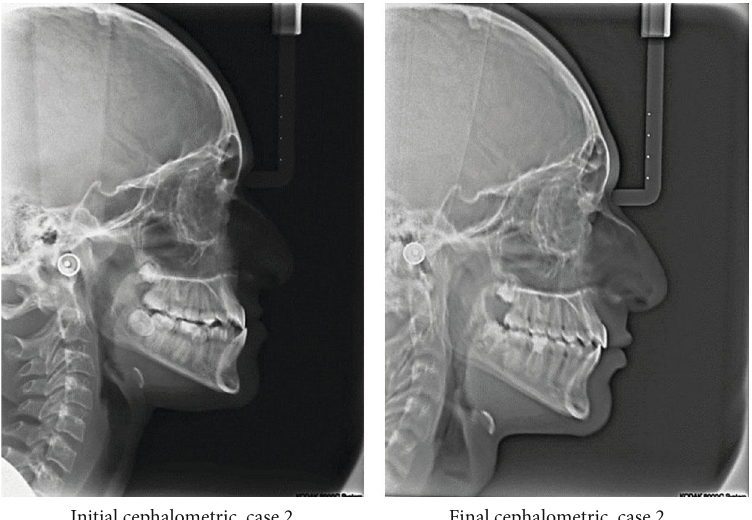
Figure 12: Initial and fi nal cephalometric radiographs.